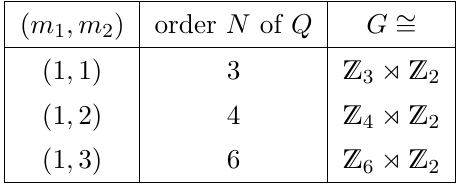
Table 1 . Choices for ( m 1 , m 2 ) with m 1 m 2 < 4 and the resulting group structure. The case m m < 4 1 2